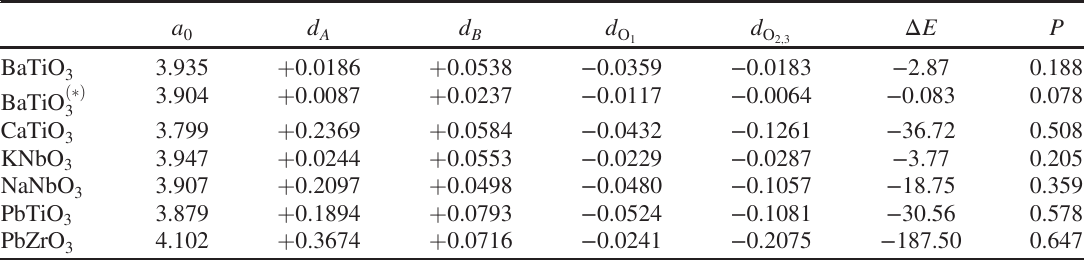
TABLE I. Data computed using DFT for six perovskite oxides: simple-cubic lattice parameter a 0 (in Å); displacements (in Å) of the atoms from their high-symmetry positions in the distorted tetragonal structure at fixed lattice constants a 0 , d κ , for the A cation ( d A ), B cation ( d B ), apical anion ( d of this relaxed tetragonal configuration with respect to the simple cubic one (in meV/f.u.); and polarization of the tetragonal phase (in C = m 2 ). (*) indicates calculations of BaTiO 3 under hydrostatic pressure; see Sec. III